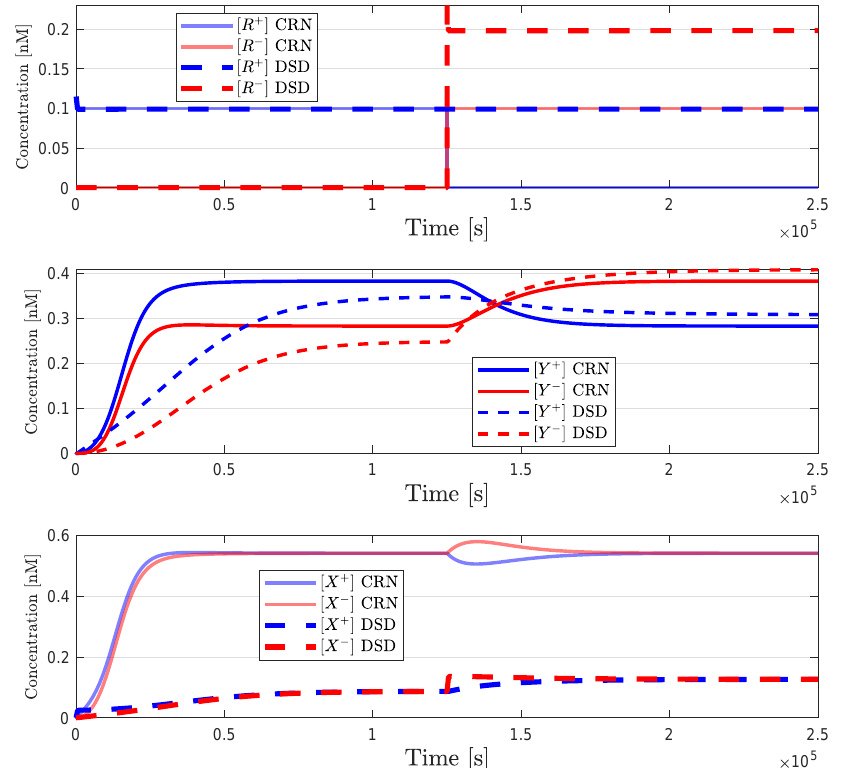
Figure 16. Simulation of the abstract CRN and the DSD implementation for the state feedback control in Example 4. The simulation of the DSD realisation has the output species Y ± steady-state close to the expected from the CRN representation. X ± , on the other hand, is smaller for the DSD